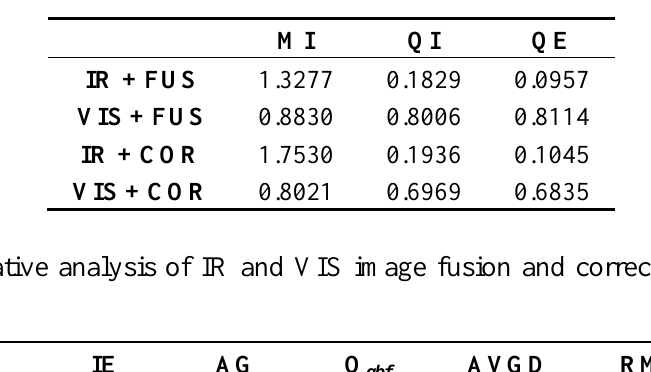
Table 4. Quantitative analysis of IR and VIS image fusion and correction (1300 LST 24 July 2006).